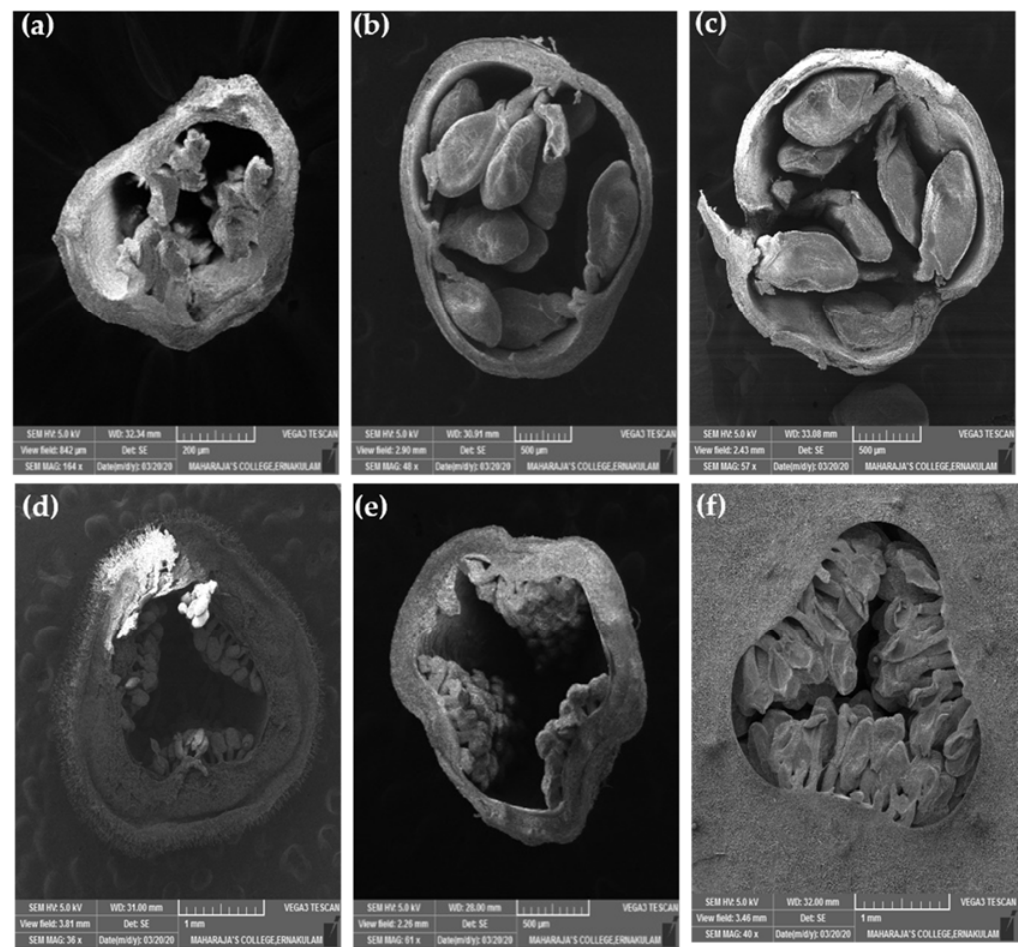
Figure 8. Ovules of a wild P. foetida ( a – c ) and a cultivated P. edulis ( d – f ) at different developmental stages viewed under scanning electron microscope.